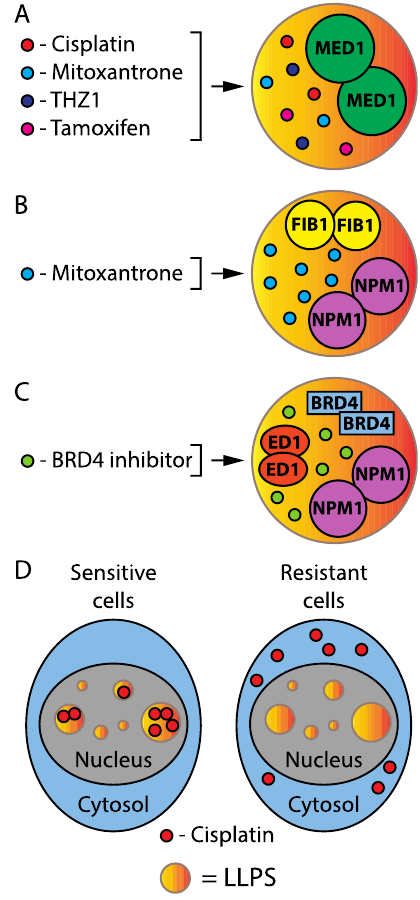
Figure 5. LLPS and cancer treatments. ( A ) Drugs found in LLPS of MED1. ( B ) Mitoxantrone can be found in LLPS of FIB1 and/or NPM1. ( C ) The BRD4 inhibitor can be found in LLPS of BRD4, ED1 and/or NPM1. ( D ) Cisplatin localizes in nuclear LLPS of treatment-sensitive cells but in the cytoplasm of treatment-resistant cells.